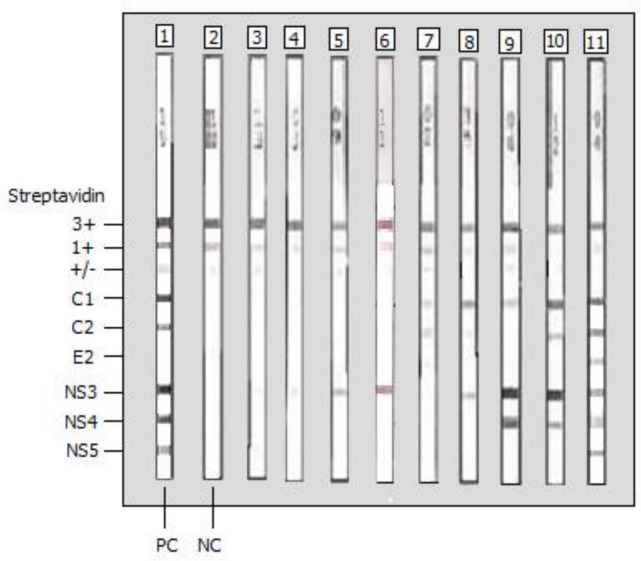
Recombinant immunoblot analysis (the INNO-LIA HCV score assay from Innogenetics) of sera from nine Gabonese HCV/HIV co-infected patients who tested positive for HCV RNA.Lane 1, HCV-positive control; lane 2, HCV-negative control; lanes 3 to 6, sera from four Gabonese HCV/HIV-1-co-infected patients with a faint (+/- or 1+) or strong (3+) isolated NS3 band (indeterminate profile); lane 7, serum from one Gabonese HCV/HIV-1-co-infected patient exhibiting C1 (1+) and C2 (1+) bands but no reactivity to E2, NS3, NS4 and NS5 (weakly positive profile); lane 8, serum from one Gabonese HCV/HIV-1-co-infected patient exhibiting C1 (3+), C2 (+/-) and NS3 (2+) bands but no reactivity to E2, NS4 and NS5 (positive profile); lane 9, serum from one Gabonese HCV/HIV-1-co-infected patients exhibiting strong (4+) reactivity to NS3 and NS4, weak (1+) reactivity to C1 but no reactivity to C2, E2 and NS5; lane 10, serum from one Gabonese HCV/HIV-1-co-infected patients exhibiting strong (3+ or 4+) reactivity to C1, C2, NS3, and NS4 but no reactivity to E2 and NS5; lane 11, serum from one Gabonese HCV/HIV-1-co-infected patient with a complete profile.